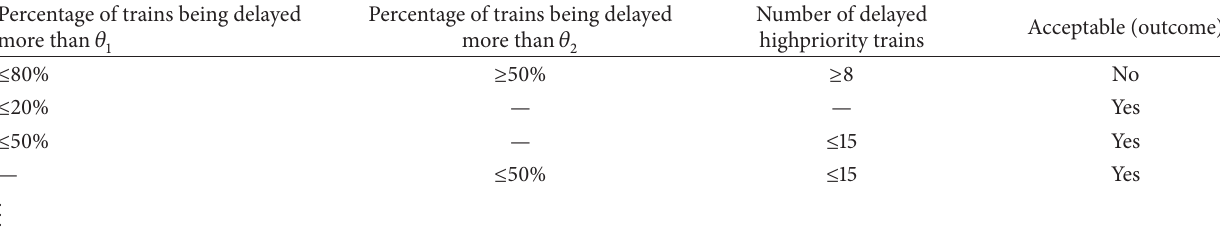
Table 2: Sets defined for